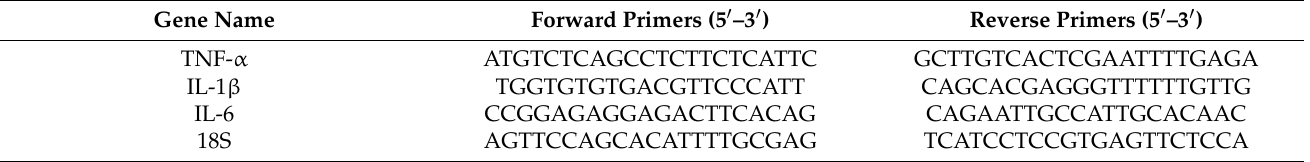
Table 5. The sequences of primers for TNF- α , IL-1 β , IL-6, and 18S used in this